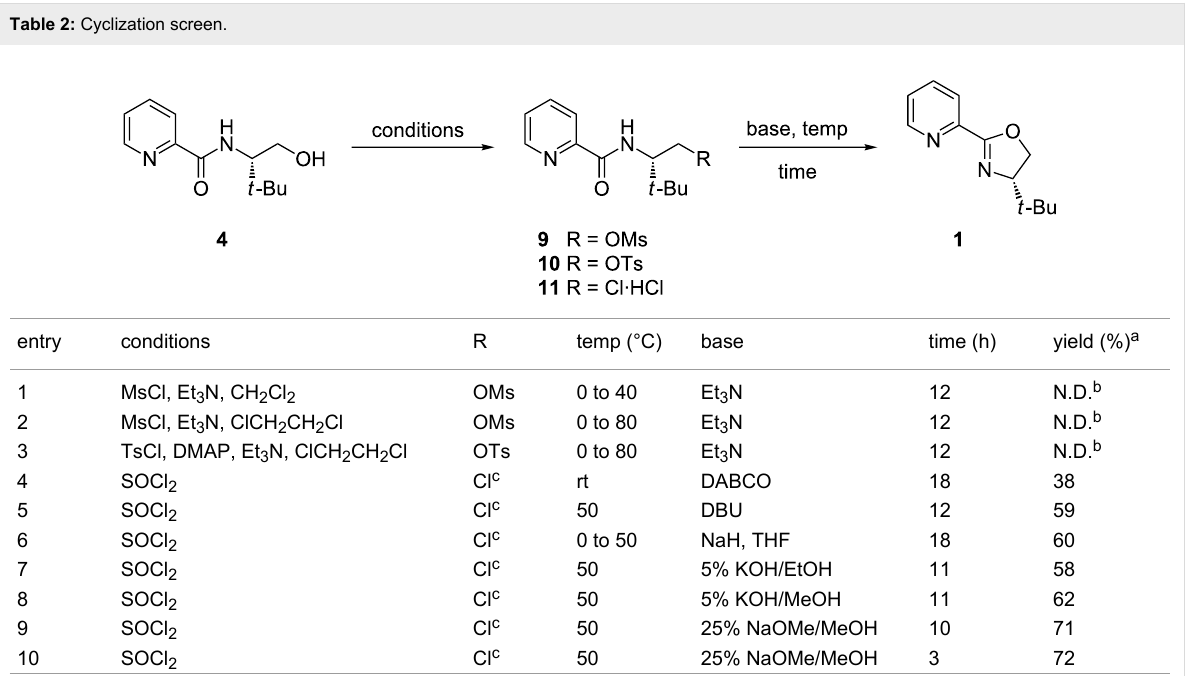
Table 2: Cyclization